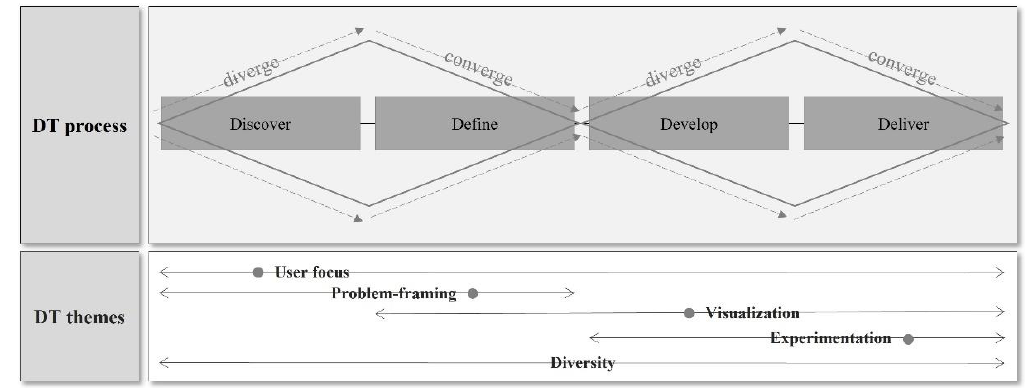
Figure 3. The relationship of DT themes with the DT process.